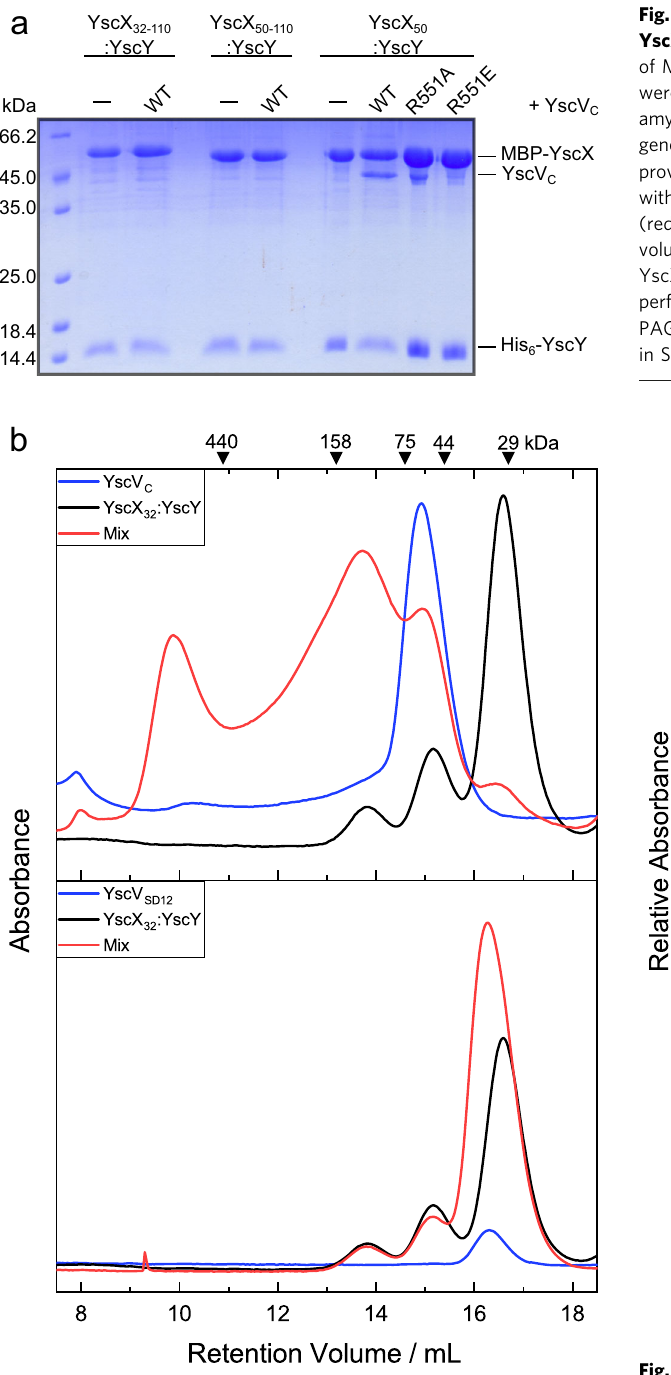
soluble 1:1 heterodimers like YscXY, but exhibit vastly different binding behaviors. A short stretch close to the N-terminus of the substrate binds to the groove formed by the chaperone ’ s concave side in extended conformation (Fig. 8b, refs. 8 – 11,46 ). The struc- ture of Aeromonas AcrH with translocator protein AopB shows further interactions between the two proteins. Analogous to the YscEFG and YscXY complex, AopB binds the N-terminal TPR of AcrH via an α -helix. In addition, AopB extensively wraps around the convex side of the chaperone, a feature neither present in YscXY nor YscEFG 11 . Thus, despite its heterodimeric nature, the